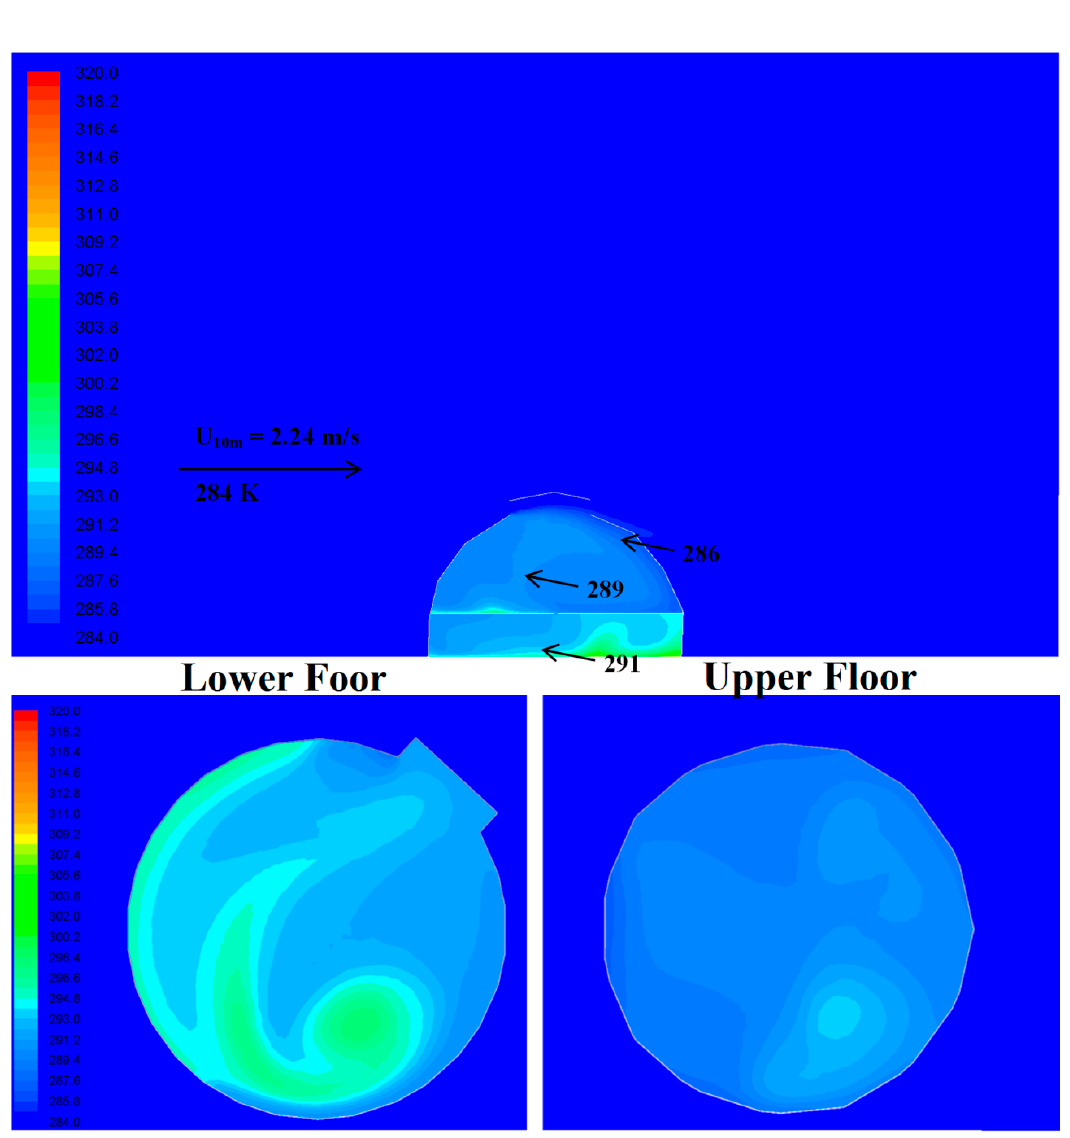
Figure 13. Comparison of the airflow velocity distribution inside the dome house during winter month of January (wind-induced flows).